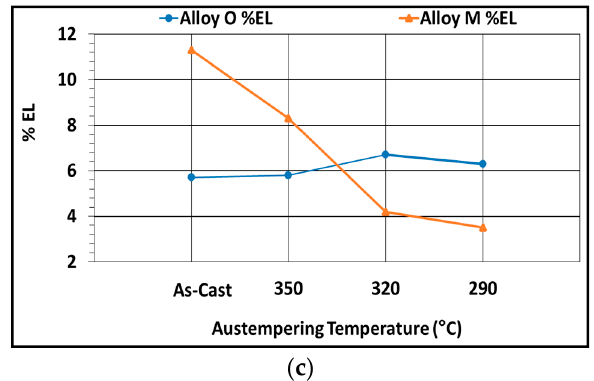
Figure 4. ( a ) Hardness, ( b ) tensile strength, and ( c ) % EL (elongation in length) values of the as-cast and austempered samples.